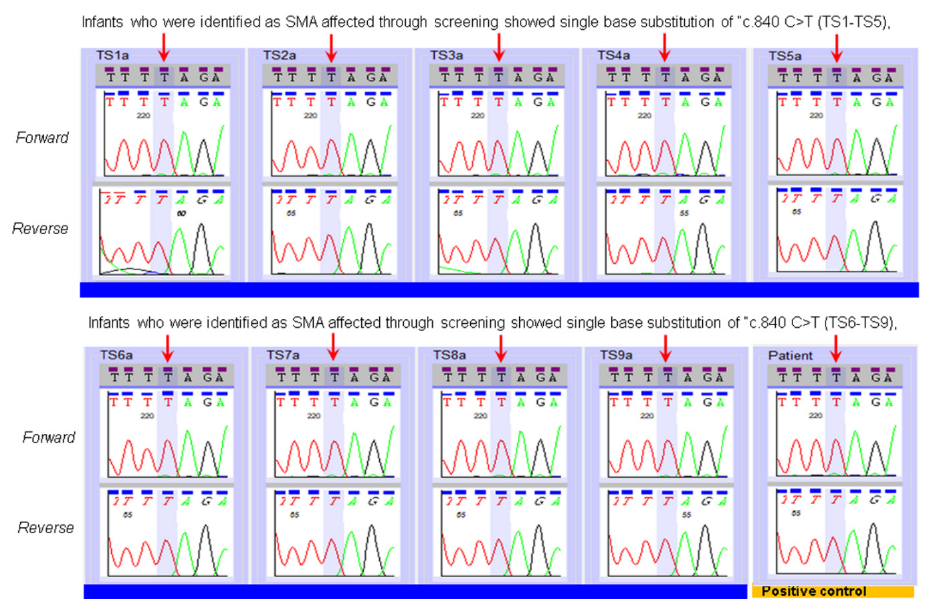
Figure 3. Typical example of SMA sequencing of specimens from nine SMA-affected infants who we referred to specialty centers through screening; all showed single base substitution of c.840C>T. During the validation of sequencing, we noted that unaffected SMA specimens re- ported to have different copy numbers of SMN1 and SMN2 behave differently at c.840 position of SMN1 in terms of fluorescence intensity of nucleotide “T” or “C”. We took advantage of this differential fluorescence intensity, and hypothesized that if we mixed